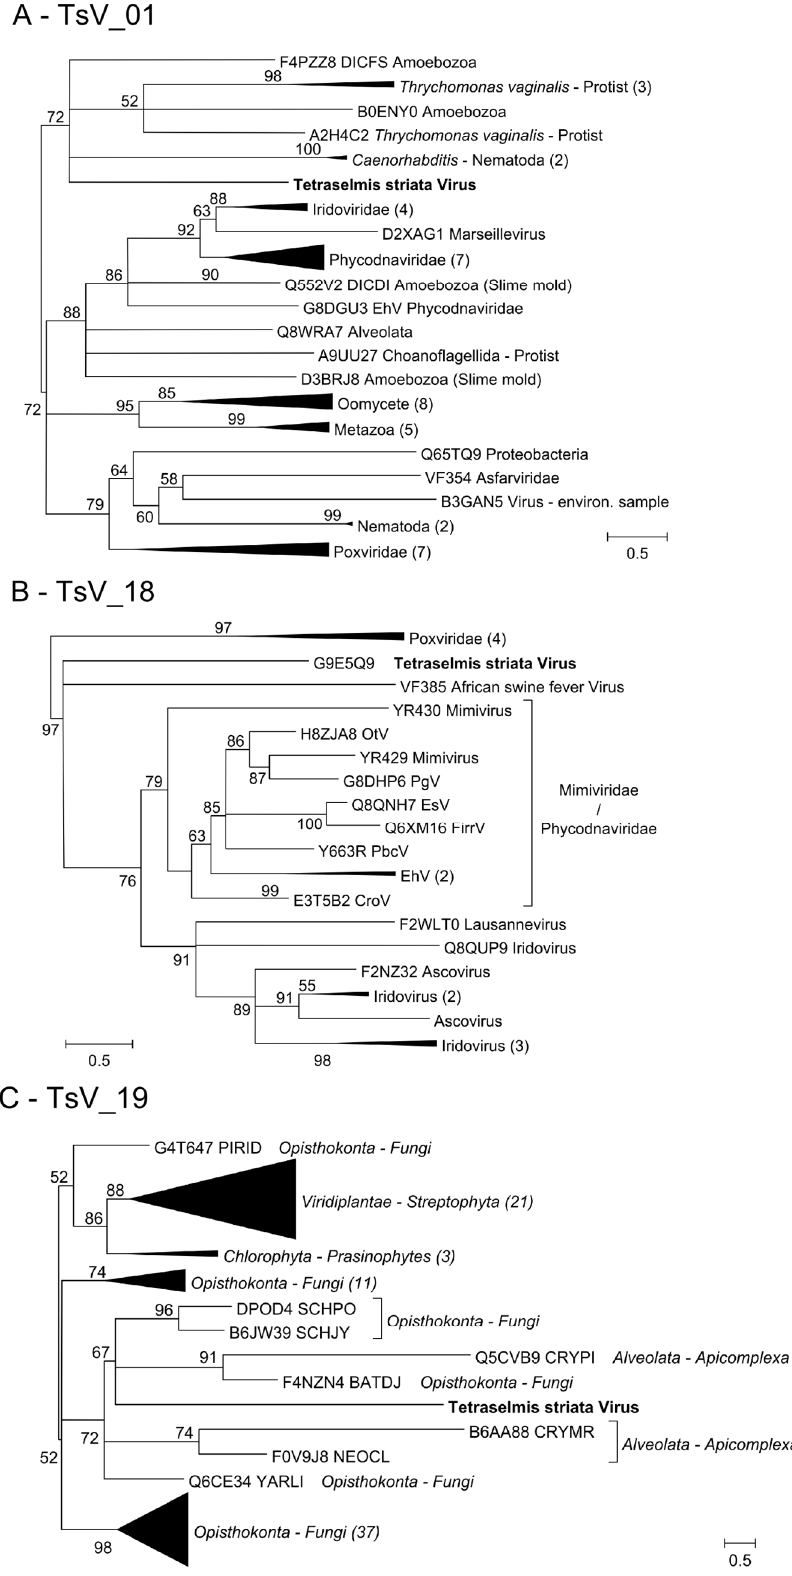
Figure 5. Phylogenies obtained for TsV_01, TsV_18, and TsV_19 genes, respectively, accompanied by homologous sequences retrieved from PFAM. Branches indicate support values obtained with Maximum Likelihood aLRT SH-like algorithm implemented in Phylogeny.fr.